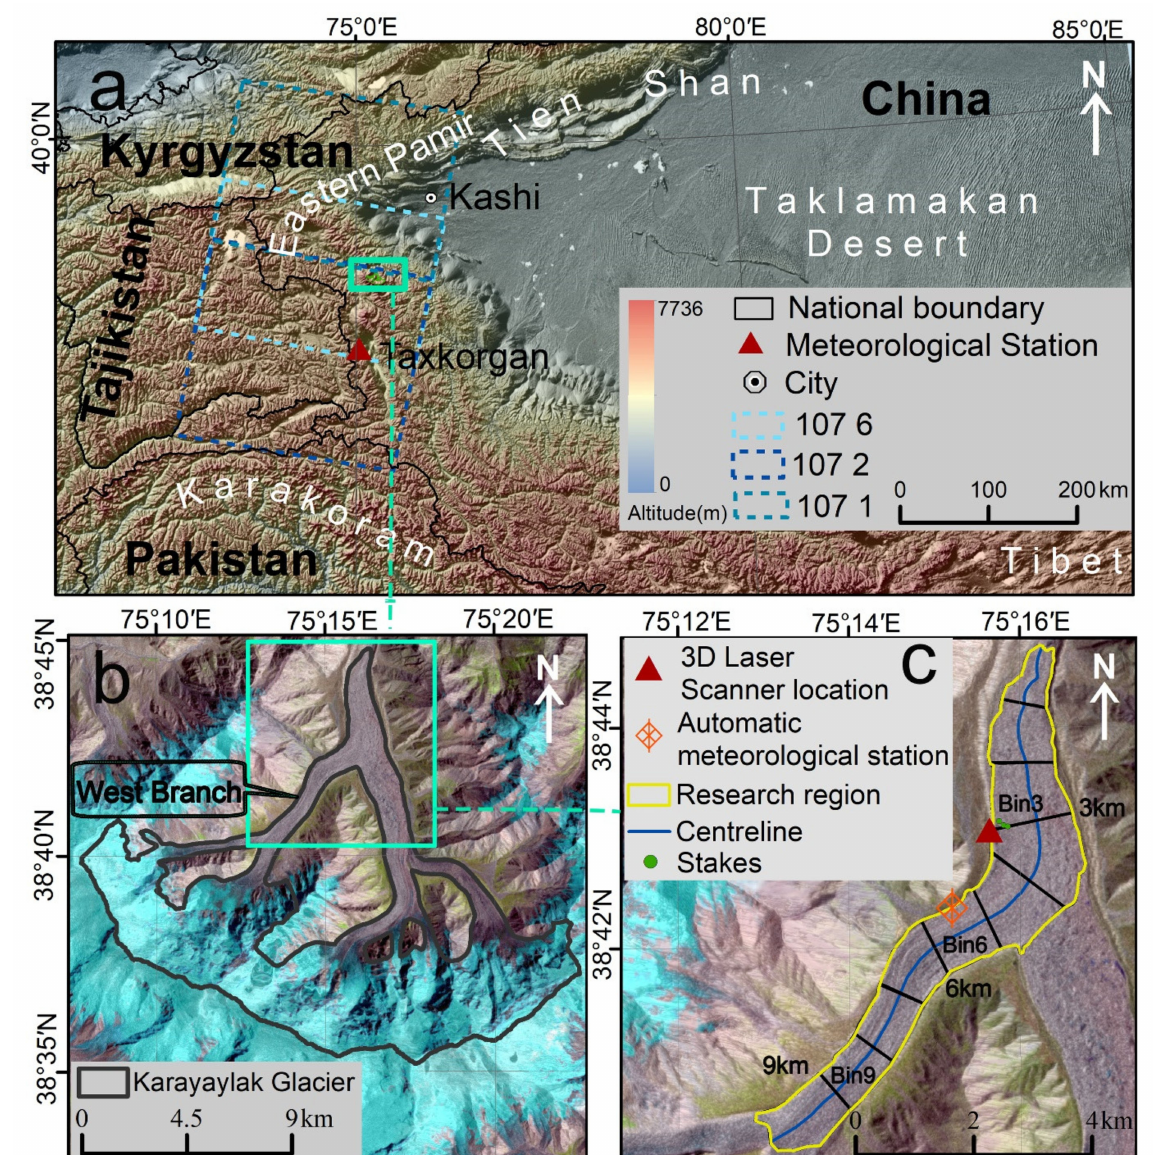
Figure 1. Panels ( a , b ) show Karayaylak Glacier’s location and the strip of Sentinel-1 imagery in this study. The two numbers of the panel ( a )’s legend represent “relative orbit number” and “slice number” of imagery. Panel ( c ) shows the velocity research region of Karayaylak glacier in this work and the locations of the 3D laser scanner and automatic meteorological station in the field investigation. Ten sub-regions separated at 1 km equidistance along the centreline are shown in panel ( c ). The Landsat 8 image at 2020/8/16 and National Aeronautics and Space Administration (NASA) Shuttle Rader Topography Mission (SRTM) digital elevation model (DEM) acted as the base